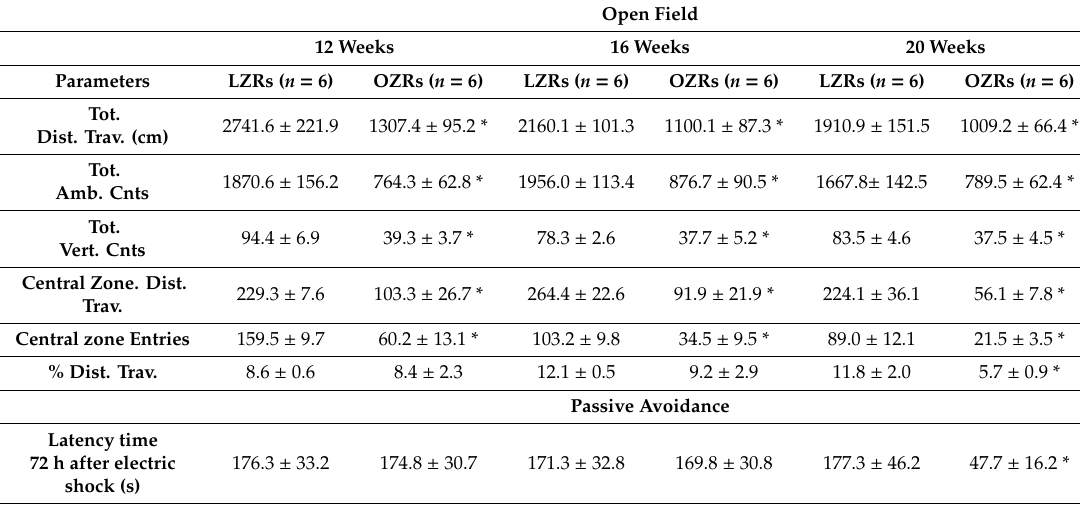
Table 4. Behavioural